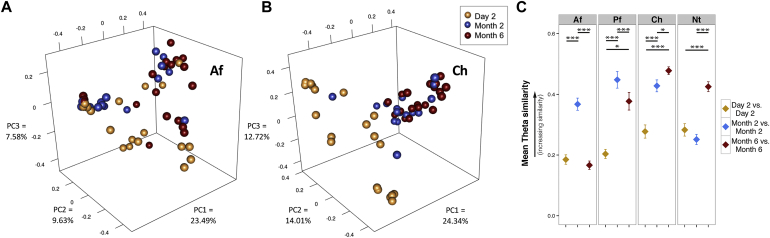
Skin microbial communities in infants undergo site-specific shifts in composition with age. A, Af samples clustered by using principal coordinates analysis based on theta similarity coefficients. By using AMOVA, samples clustered distinctly between day 2 and month 6 (P = .024) but not significantly between month 2 and month 6 (P = .12) or between day 2 and month 2 (P = .21). B, Cheek samples clustered by using principal coordinates analysis based on theta similarity coefficients. By using AMOVA, samples clustered significantly between day 2 and month 6 (P < .003) and between month 2 and month 6 (P < .003) but not between day 2 and month 2 (P = .102). C, Mean theta similarity coefficients of comparisons within samples of each time point. Higher theta values signify greater similarity. *P < .05 and ***P < .001, Wilcoxon rank sum test. Post hoc P values were adjusted with the Bonferroni correction (n = 3). Ch, Cheeks; PC, principal component.